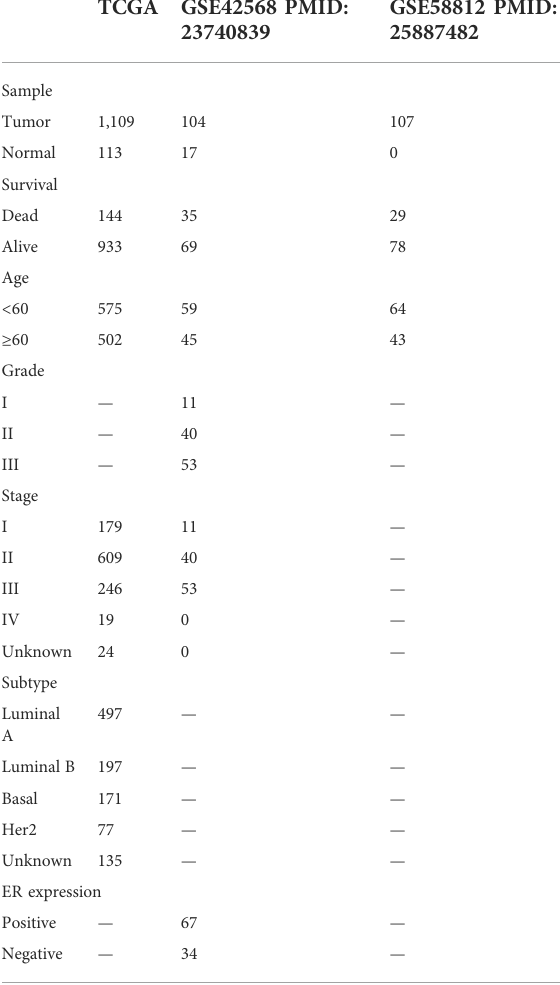
TABLE 1 Clinical information of TCGA, GSE42586, GSE58812. TCGA GSE42568 PMID: